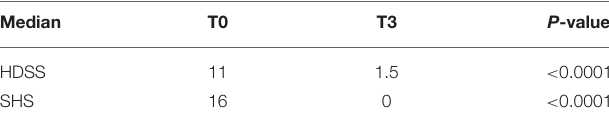
TABLE 3 | Differences among the median values of Hemorrhoidal Disease Symptom Score (HDSS) and Short Health Scale (SHS) between baseline (T0) and 3 month follow up